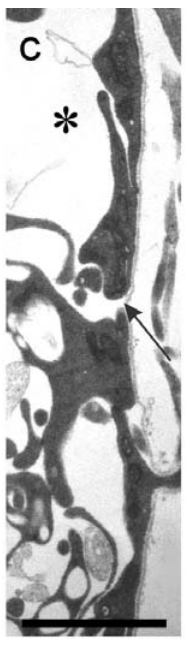
Figure 3. Electron micrograph of a section of neural tube derived from an E11 rat embryo at a presumptive motor exit point. A transverse section of the neural tube shows a thin layer of uninterrupted basal lamina that overlies glial end-feet, which form a conspicuous gap at a presumptive motor exit point. Black arrow, presumptive motor exit point; black asterisk, space found within presumptive white matter. Scale bar: 2 μ m